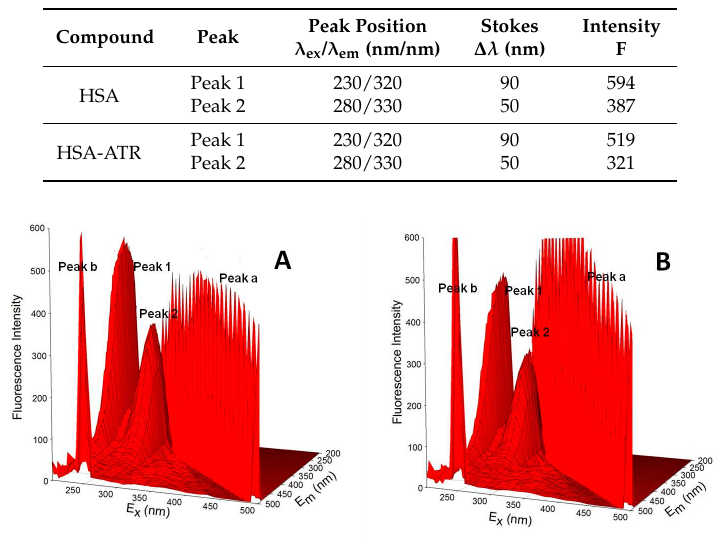
Figure 9. Three-dimensional fluorescence spectra of free HSA ( A ) and HSA complexed with the ATR ( B